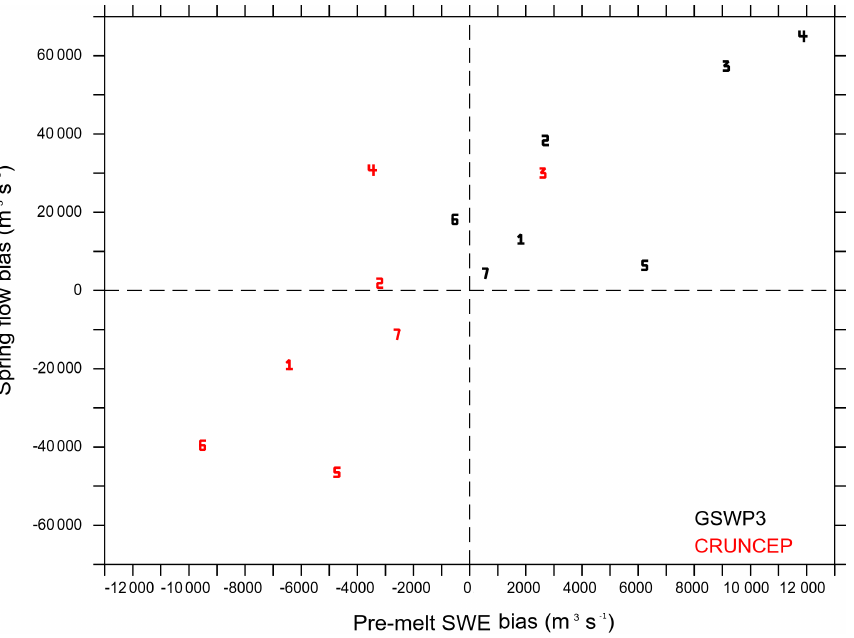
Figure 22. Scatter plot of the pre-melt SWE bias (m 3 s − 1 ) defined as the difference between simulated and observed values during the pre-melt season (between February and March) vs. the spring river discharge bias (total discharge at the mouth of the river between April and June) (m 3 s − 1 ), averaged over the period 1981–2007. Each number corresponds to one basin: 1: Yukon, 2: Mackenzie, 3: Volga, 4: Ob, 5: Yenisei, 6: Lena and 7: Kolyma (see Fig. 2b). One color represents the result with one atmospheric